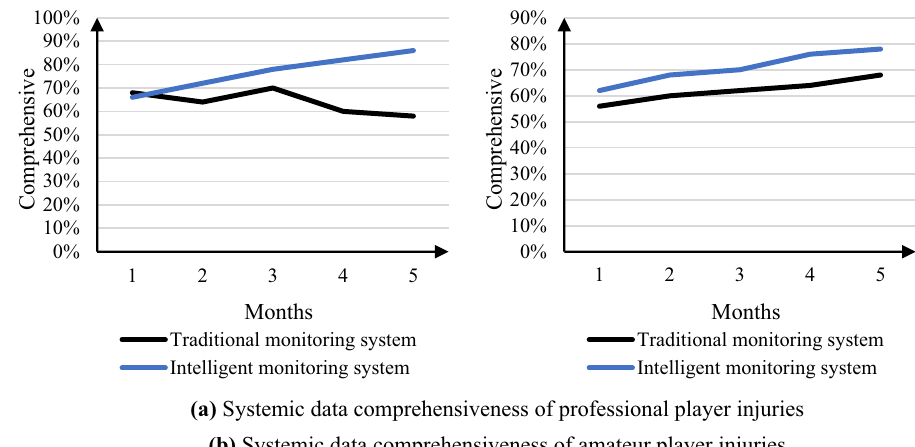
(a) Systemic data comprehensiveness of professional player injuries